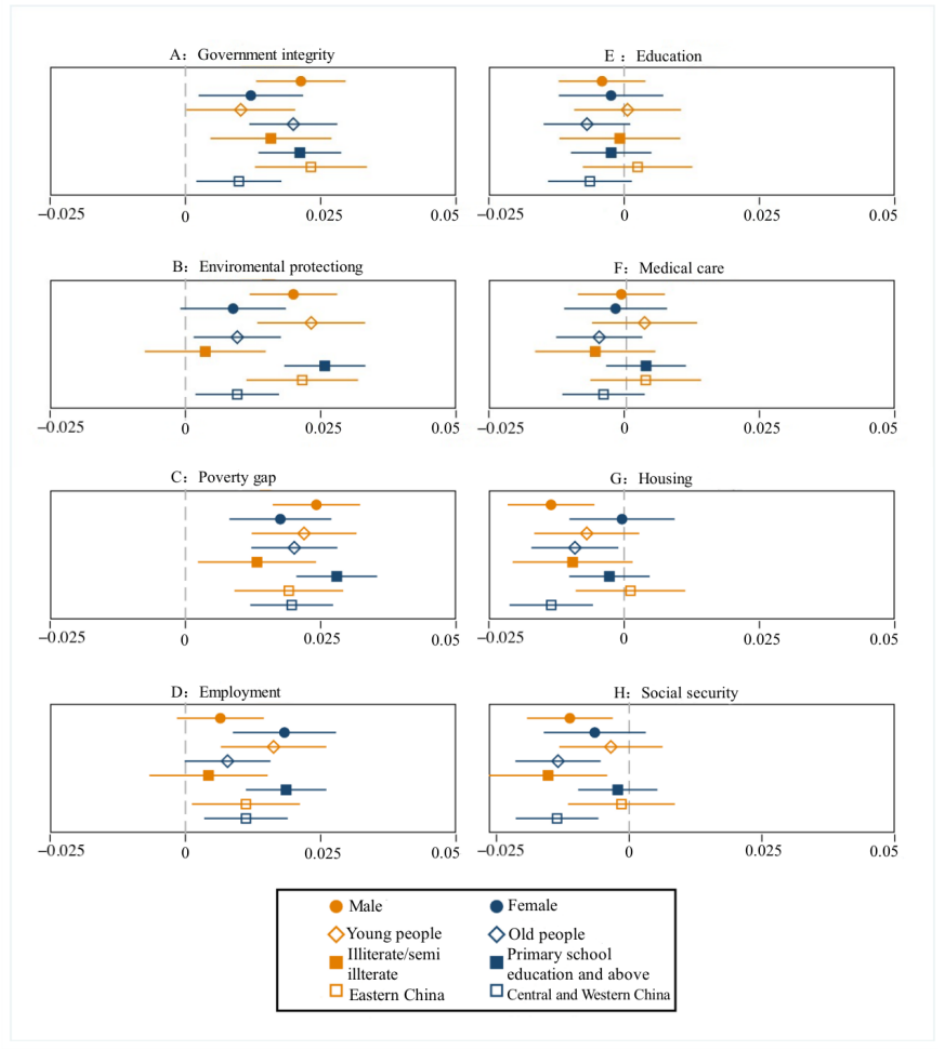
Figure 6. Differences in the impact of TV use on the satisfaction with social environment among different groups.